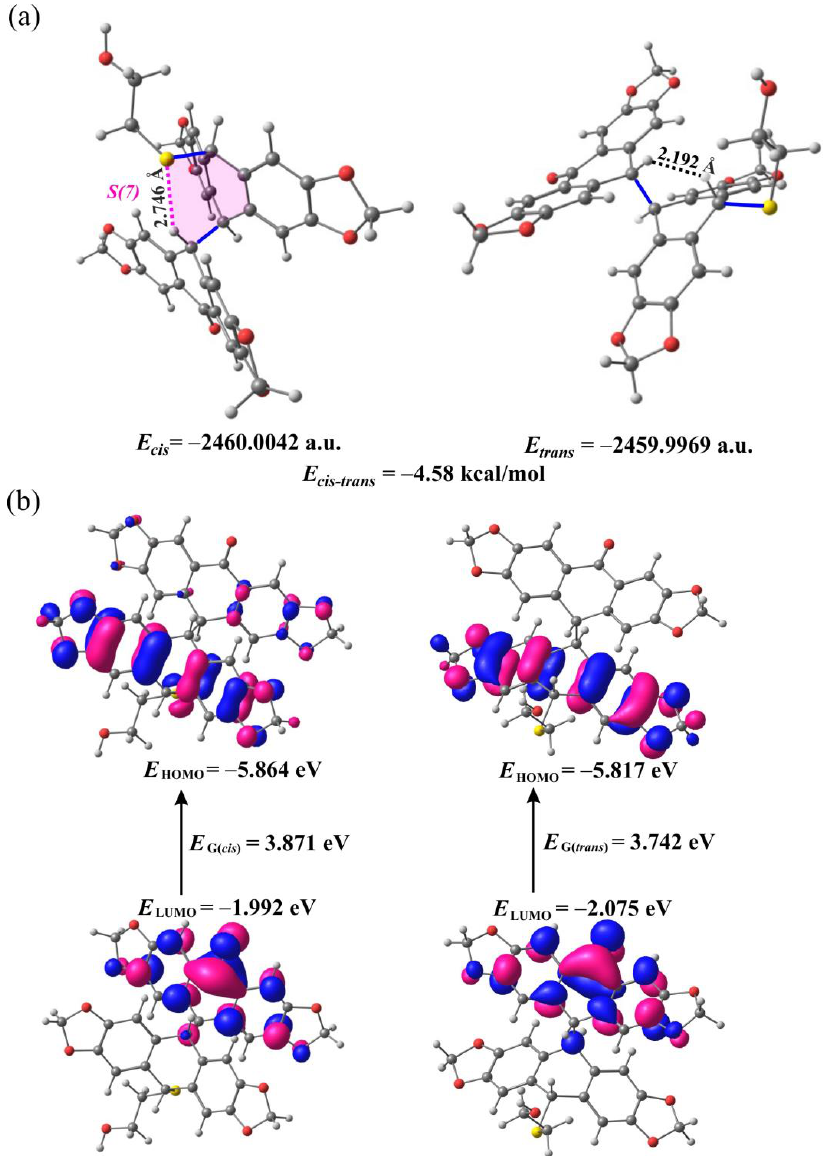
Figure 2. Molecular structures cis - 9b and trans - 9b ( a ) and their HOMO and LUMO orbitals ( b ) optimized at the DFT theory B3LYP/6-31++G(d,p). The dashed pink and black lines denote non-covalent C-H···S and H···H interactions, respectively. The blue solid lines show cis and trans configurations.